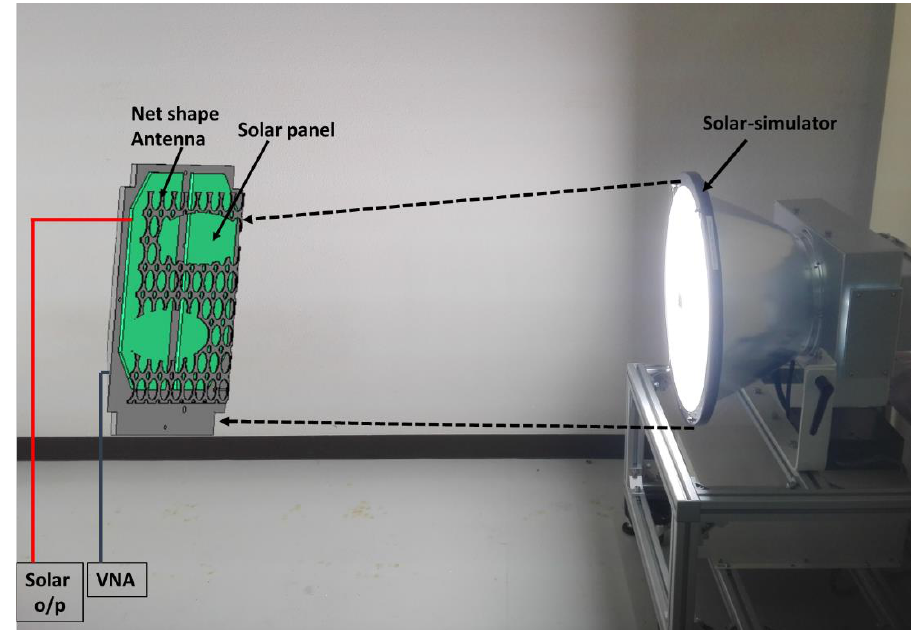
Figure 6. Solar power output investigation with antenna structure integration. Table 2. Solar panel output power investigation of the proposed antenna.